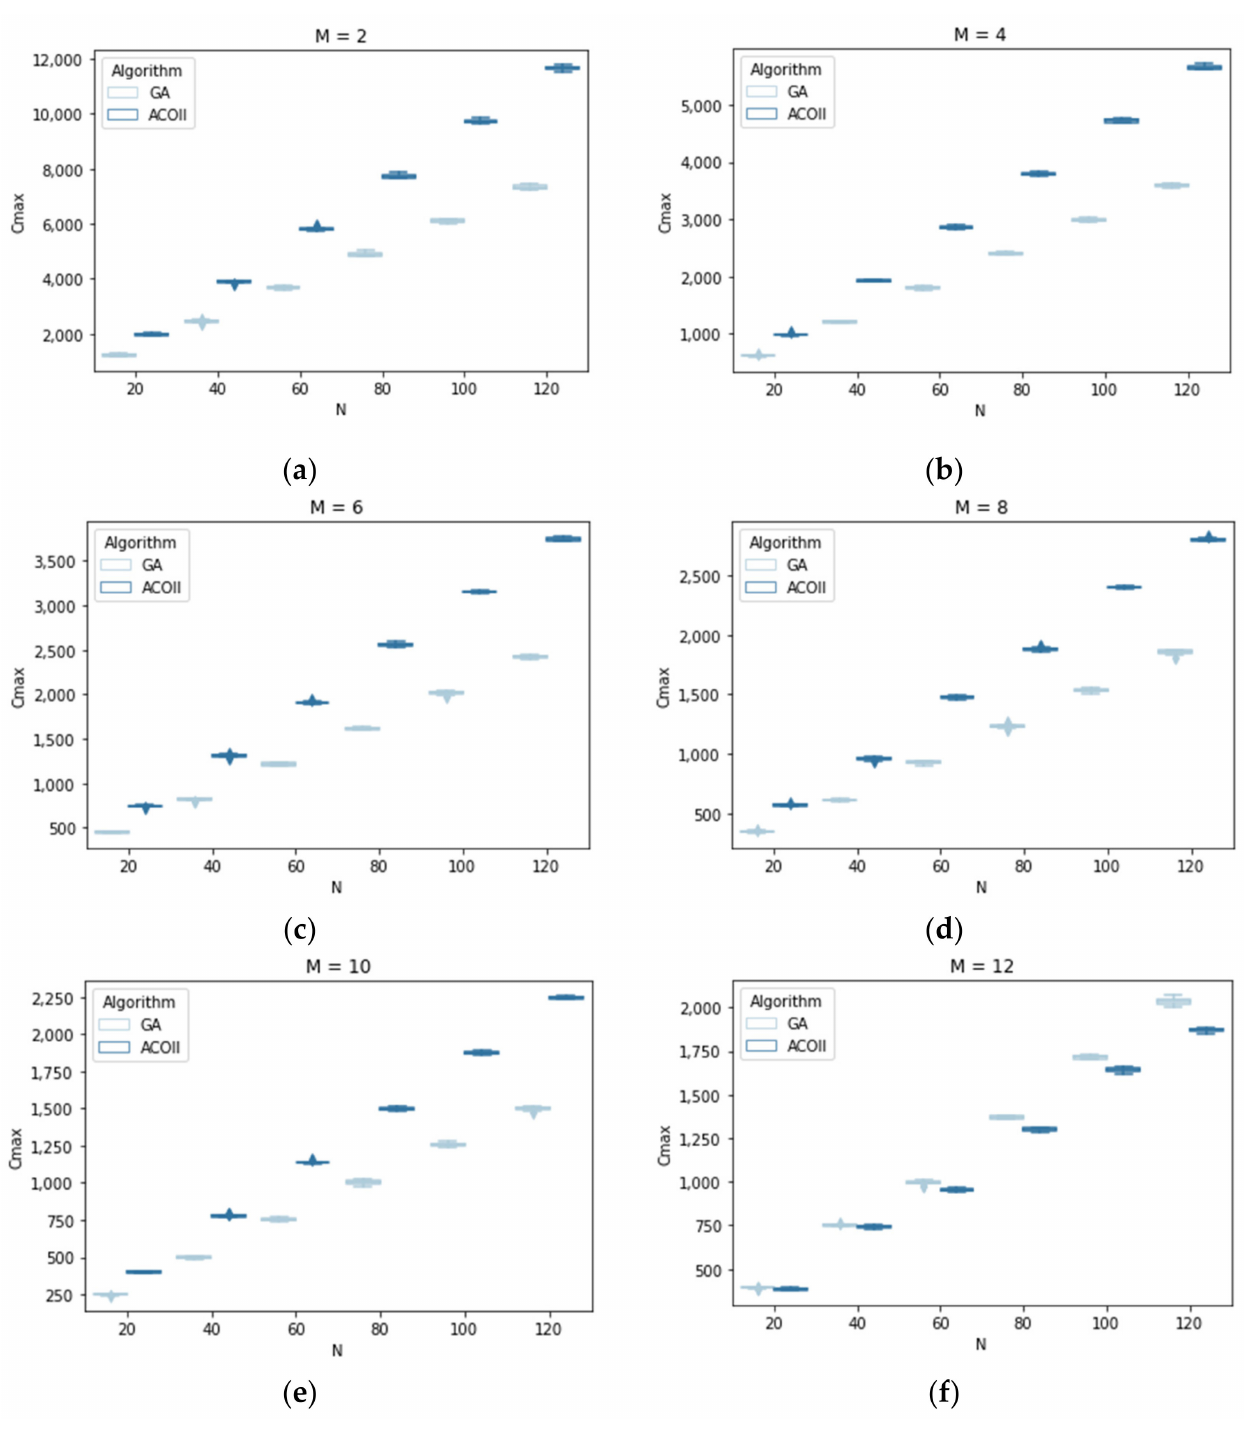
Figure 2. Makespan boxplot for Dominant P large problems for ( a ) M = 2; ( b ) M = 4; ( c ) M = 6; ( d ) M = 8; ( e ) M = 10; ( f ) M =